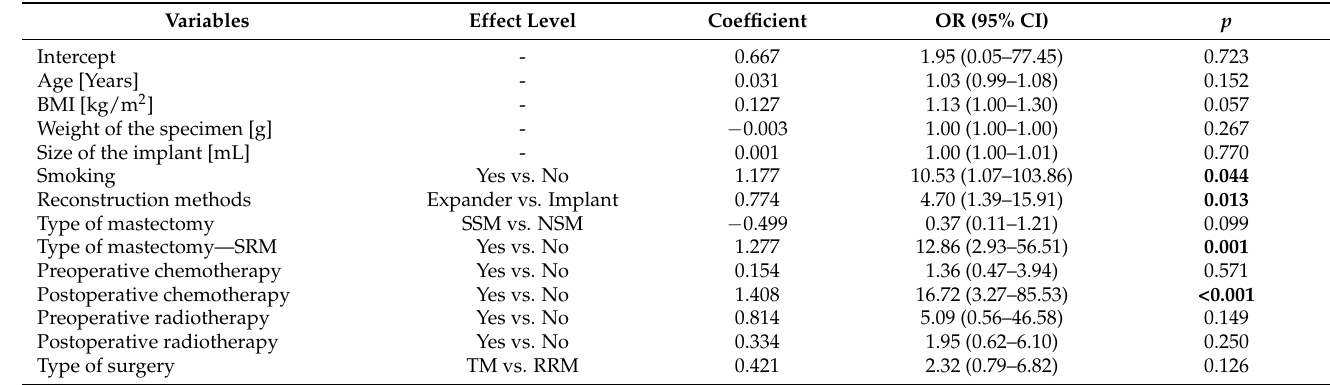
Table 5. Multivariate logistic regression of factors potentially associated with achievement of the composite endpoint (minor and major complications after breast reconstruction including presence of seroma).